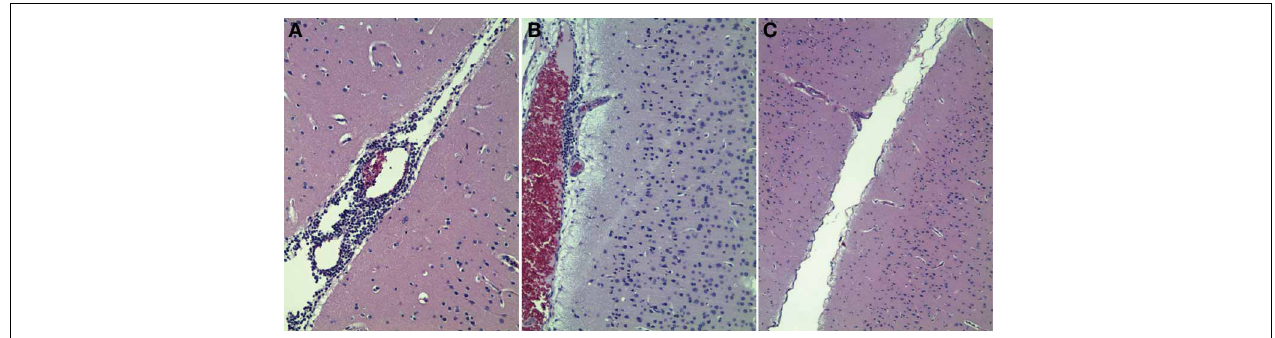
FIGURE 1 | Histologic examination of macaque brain tissues of animals infected with B. melitensis. Two of six animals infected with Brucella had evidence of focally mild to moderate nonsupperative encephalitis (A,B) . Four of six animals had no histologic evidence of encephalitis (C) .